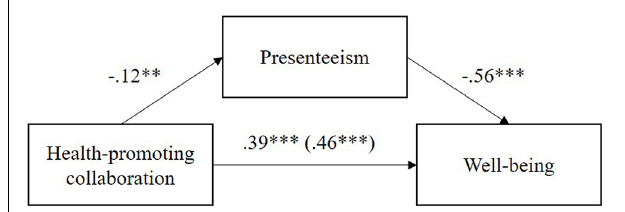
FIGURE 1 | Presentation of the B -values of the mediator analysis with the criterion well-being. The B -value of the total effect is given in parentheses. ***p < 0.001, ** p < 0.01.